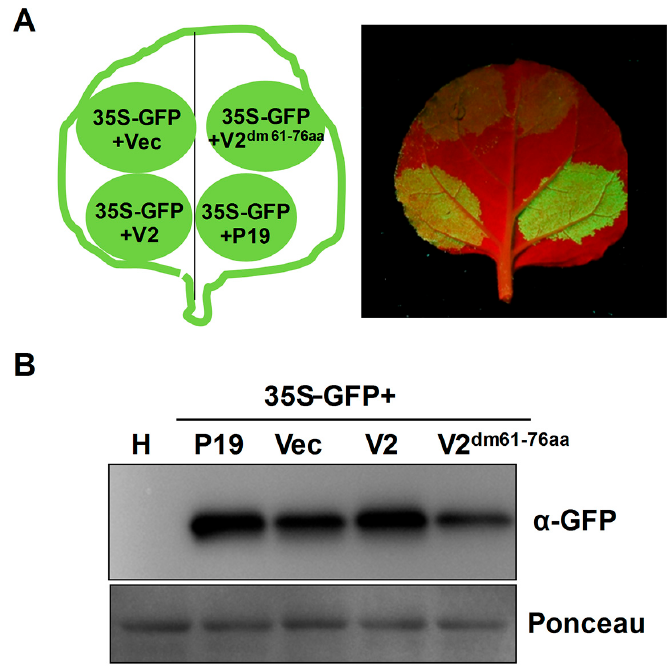
Figure 6. Deletion of the basic motif of MMDaV V2 influences its RNA silencing activity. ( A ) Suppression of RNA silencing in N. benthamiana plants. Leaf patches were infiltrated with a mixture of Agrobacterium cultures containing constructs represented in the left panel. Photographs were taken under UV light at 3 dpi. Three independent infiltration experiments were carried out, and four plants were used per experiment. ( B ) Western blot analysis of the GFP protein levels in infiltrated leaf patches using a monoclonal antibody against GFP. Total proteins extracted from the healthy N. benthamiana plant (H) were used to detect the specificity of the GFP antibody. Ponceau staining of the large subunit of Rubisco was used as loading controls.